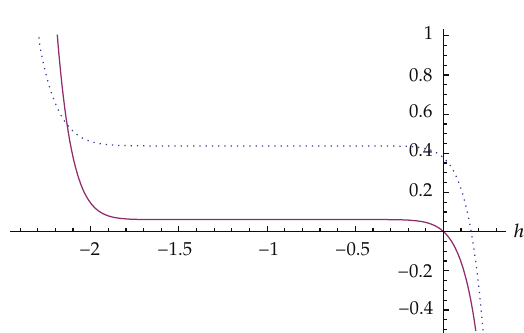
Figure 4: The ħ -curve of at 14th-order approximation solid line u (cid:2) 1 , 1 (cid:3) ; dotted line ˙ u (cid:2) 1 , 1 (cid:3) .